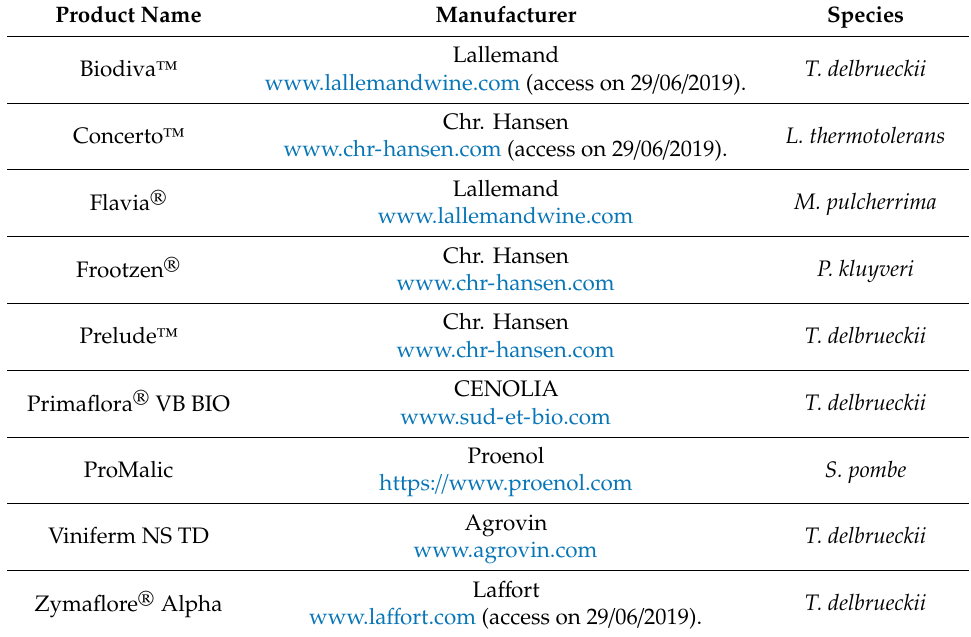
Table 2. Main commercial products that contain non- Saccharomyces